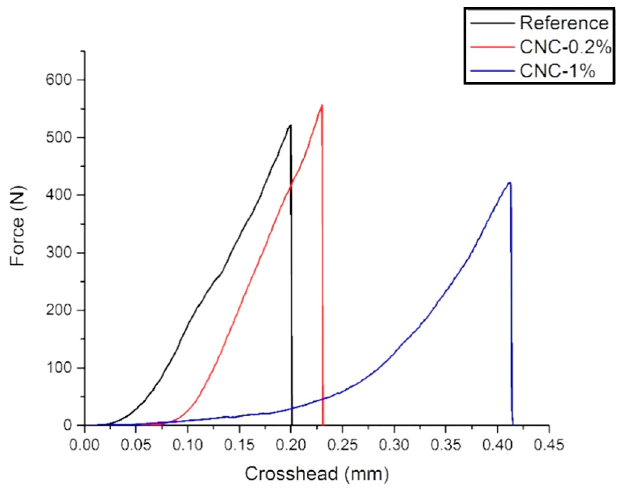
Figure 4. Three-point bending test for the 28 days samples.